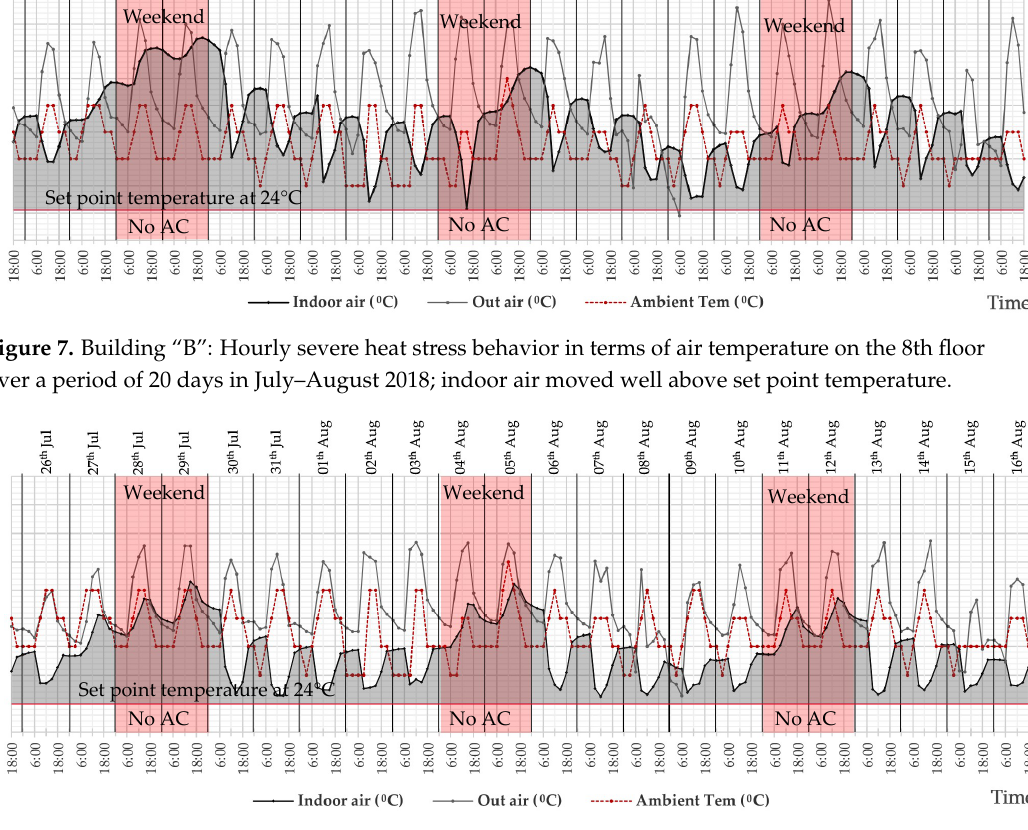
Figure 8. Building “A”: Hourly moderate heat stress behavior in terms of air temperature in the 8th floor over a period of 20 days in July–August 2018. Indoor air moved closer to set point but at a much higher energy cost of BEI.